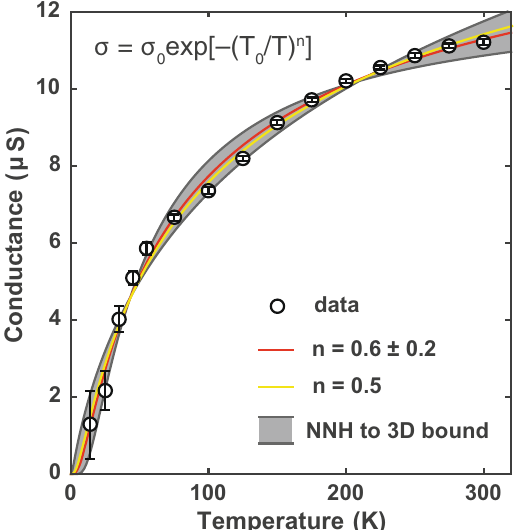
Figure 5. The temperature dependence for 1D transport The measured conductance at zero bias voltage and zero gate voltage as a function of temperature. The ‘best’ fit to the data (solid red line) gives a value n = 0.6 ± 0.2. A plot of the multi-channel Luttinger theory with n = 0.5 is also presented. The extracted transition temperature T = 13 ± 6 K is just below our measurement range, and does therefore not allow us to observe the onset of a Thouless crossover into the strong localization regime at low temperature. The grey shaded area indicates the bounds from excitation to the mobility edge or nearest neighbour hopping (NNH) 44 to 3D variable range hoping 45